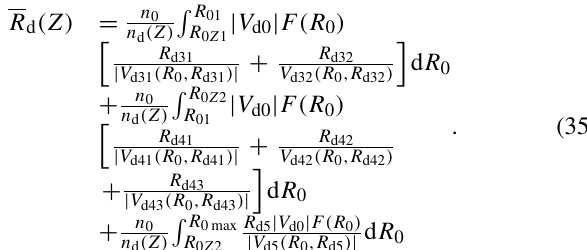
3. R 01 <R 0 <R 0 Z 2 : ice particles pass through Z three times. The corresponding radii and velocities at Z are defined as R d41 , R d42 , and R d43 and V d41 , V d42 , and V d43 .